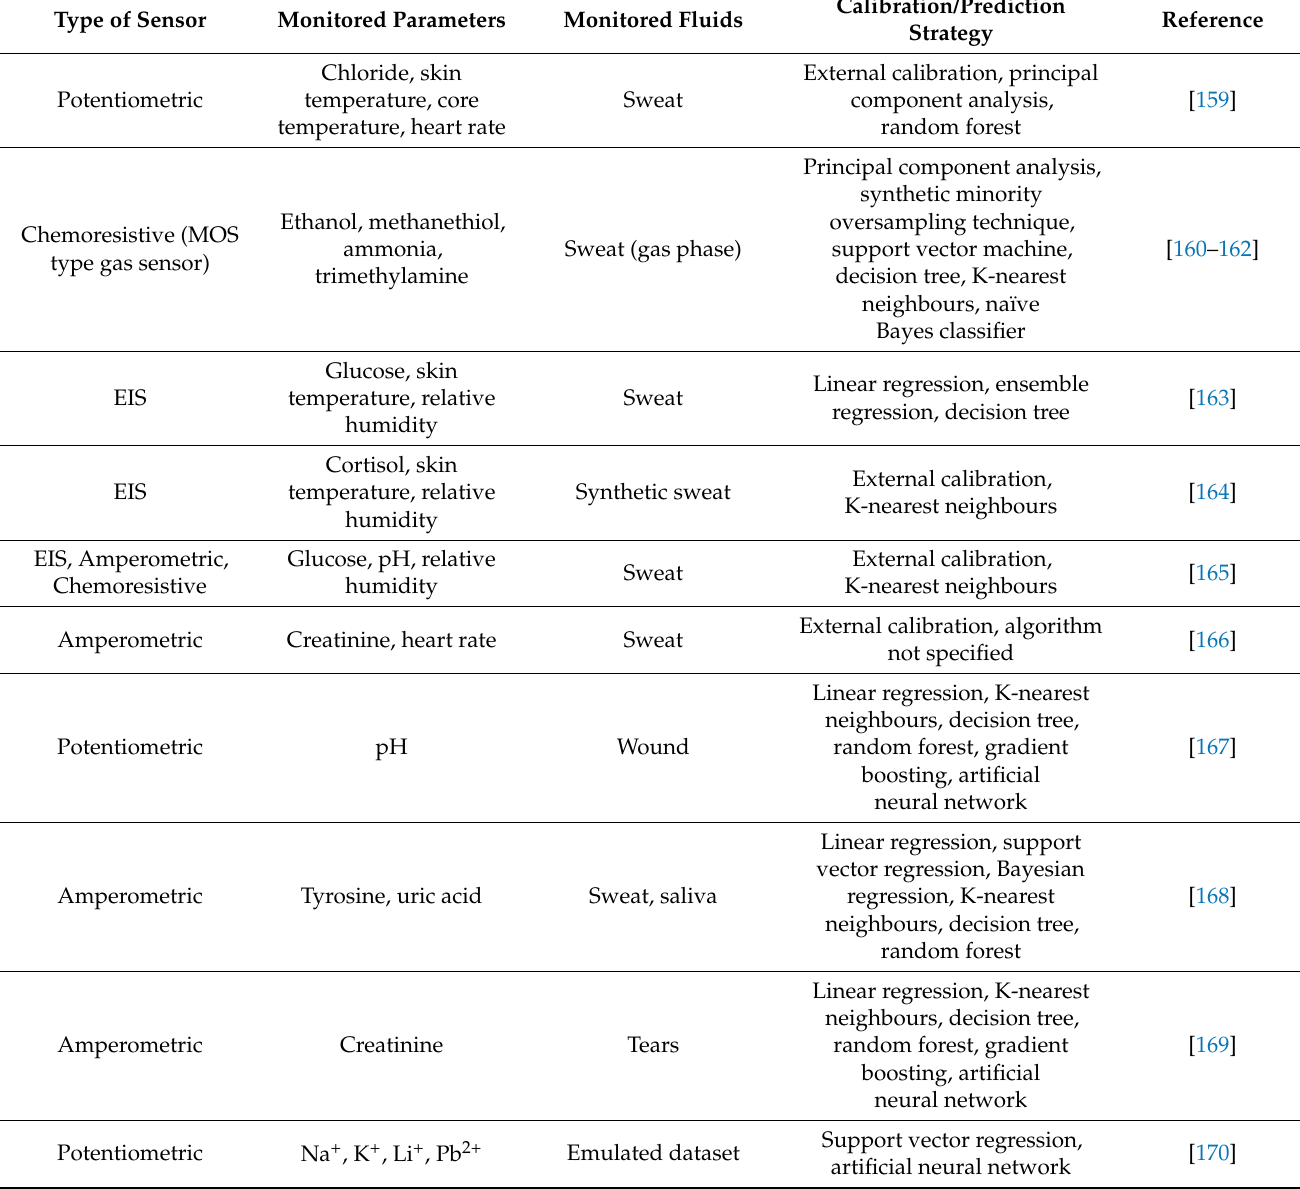
Table 6. Recent applications of ML for the optimization of monitoring relevant analytes from body fluids using electrochemical sensors. EIS: electrochemical impedance